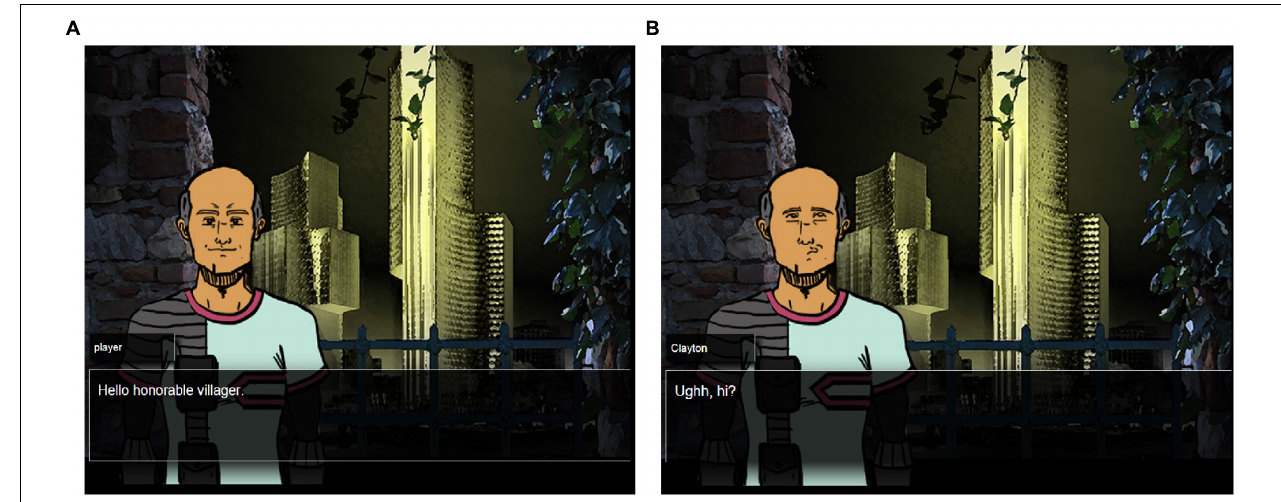
FIGURE 2 | (A) Shows the positive response to the “Formal Greet” action as displayed in the game. (B) Shows the negative response to the “Informal Greet” as a subtle